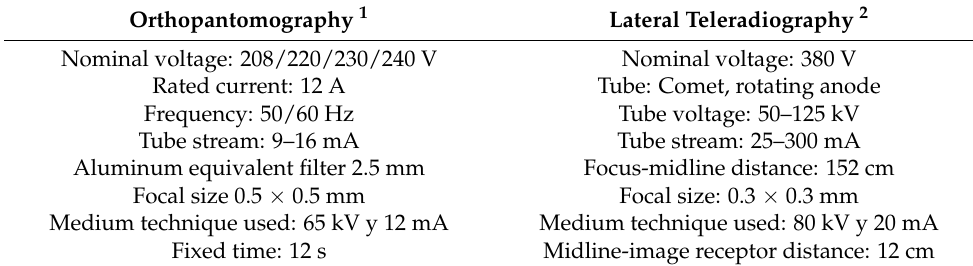
Table 1. Radiograph technical